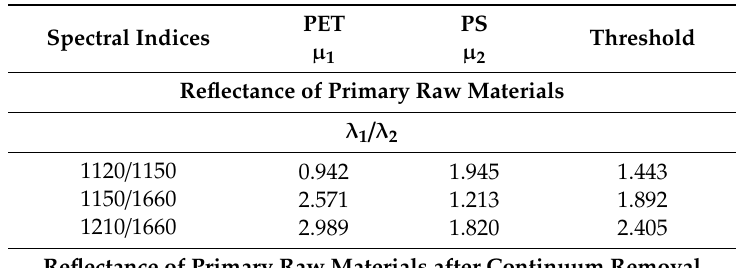
Table 6. First set of spectral indices for the pair PET-PS. λ 1 / λ 2 ( λ 1 – λ 2 ) are computed as the ratio among reflectance values at wavelengths λ 1 and λ 2